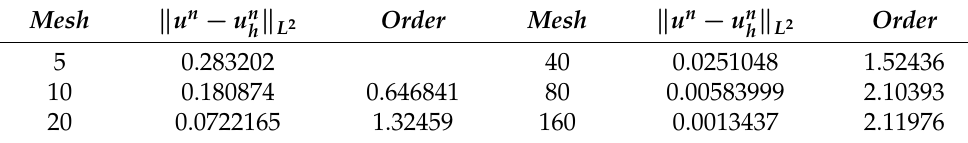
Table 1. Numerical errors and convergence rates for Experiment 1.